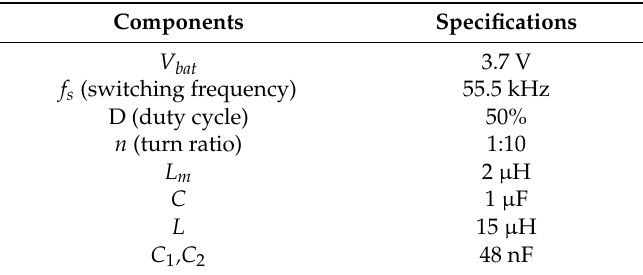
Table 2. Specifications of the utilized components.